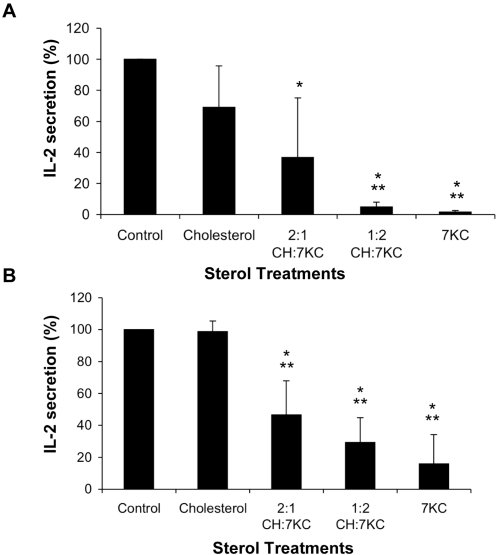
IL-2 secretion from stimulated sterol-enriched T cells.Jurkat 8.2 cells (A) and primary mouse T lymphocytes (B) were sterol treated with cholesterol and 7-ketocholesterol at the indicated ratios. Jurkat 8.2 cells were stimulated with antigen-conjugated B cells (A) and antigen exposed mouse T lymphocytes were activated with anti-CD3 mAb-coated beads (B). IL-2 secretion was determined by ELISA after 24h incubation. One and two asterisks indicates a significant difference to control cells of P<0.05 and P<0.001, respectively.